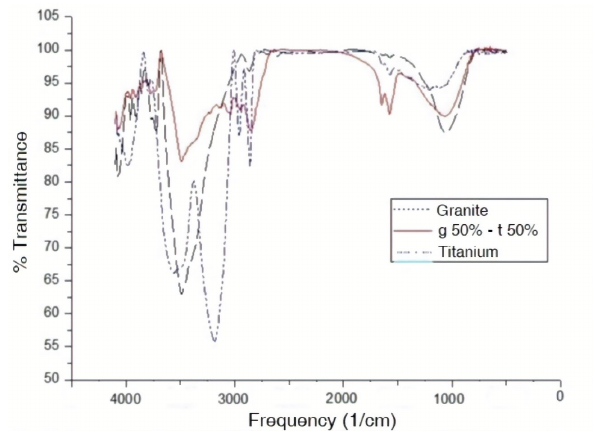
Figure 9: Sample transmittance graph with 50% granite powder + 50% titanium oxide, compared to the peaks with samples of 100% titanium oxide and 100% granite